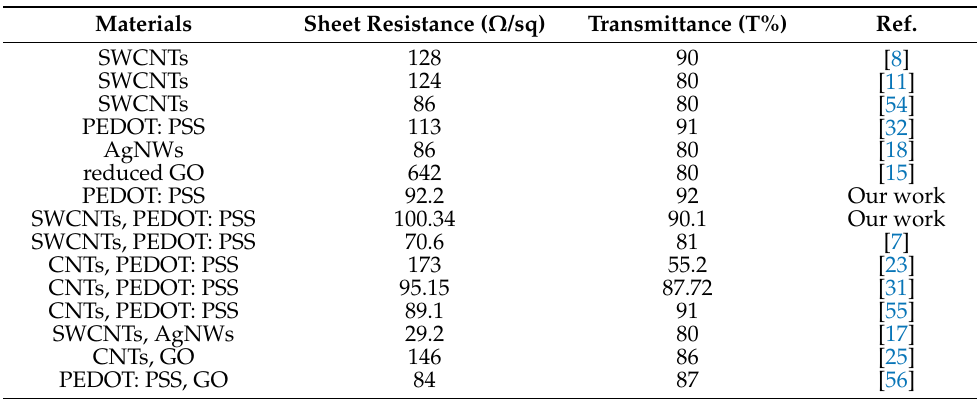
Table 2. A comparison of the electric and optical properties of different types of transparent con- ductive films.